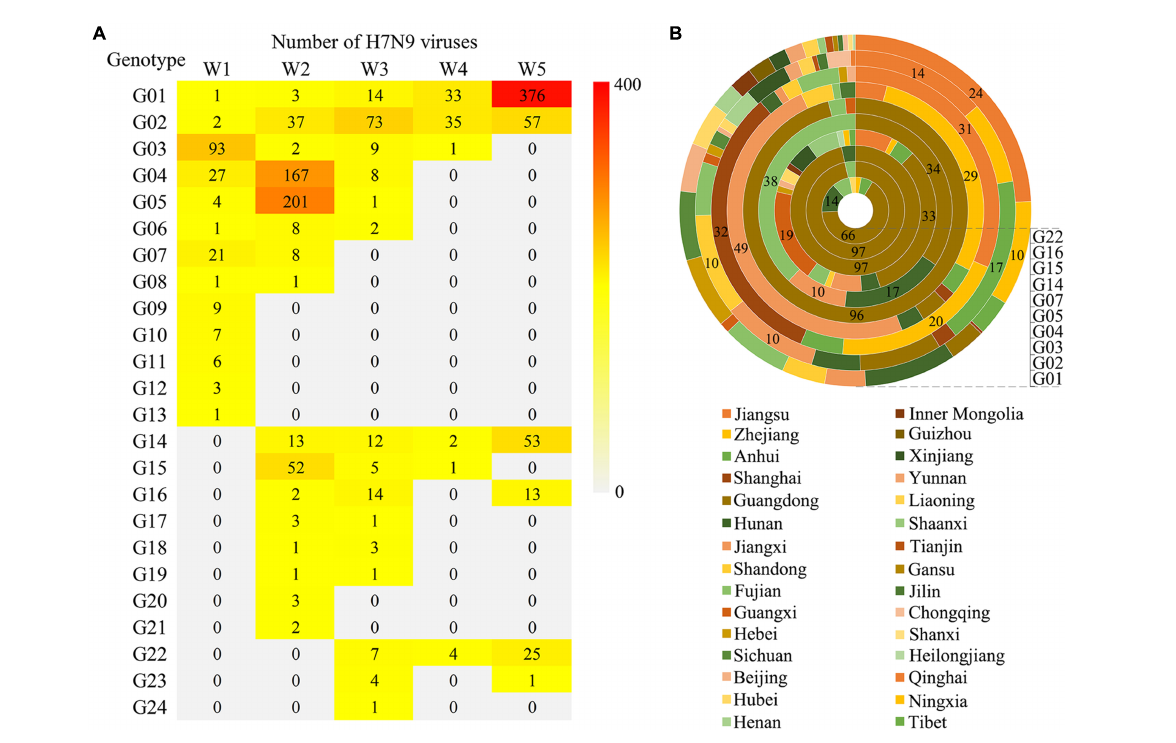
FIGURE4 Spatio-temporal distribution of the H7N9 viruses belonging to the 24 genotypes. (A) The number of the viruses corresponding to each genotype isolated in each wave. (B) Provincial distribution of ten major genotypes. Layers of the doughnut chart from the outside to the inside represent G01, G02, G03, G04, G05, G07, G14, G15, G16, and G22, respectively. The number labels the percentage of the viruses isolated from each